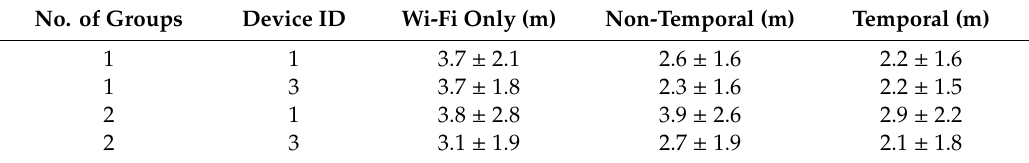
Table 5. Average positioning errors per device for two-user